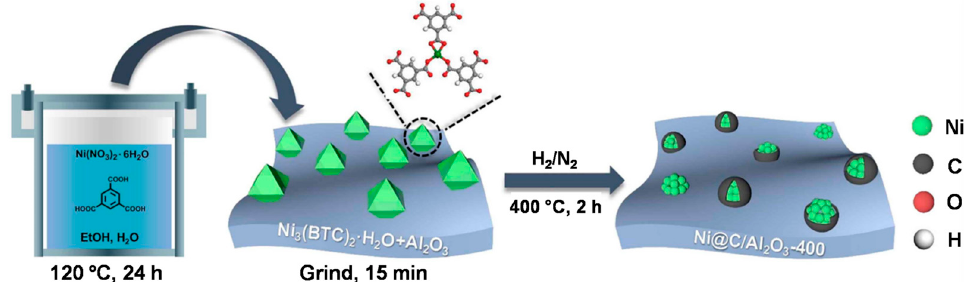
Figure 4. Schematic illustration for the synthesis procedure of a Ni@C/Al 2 O 3 -400 catalyst. Adapted with permission from ref [65]. Copyright 2022 Wiley-VCH GmbH .